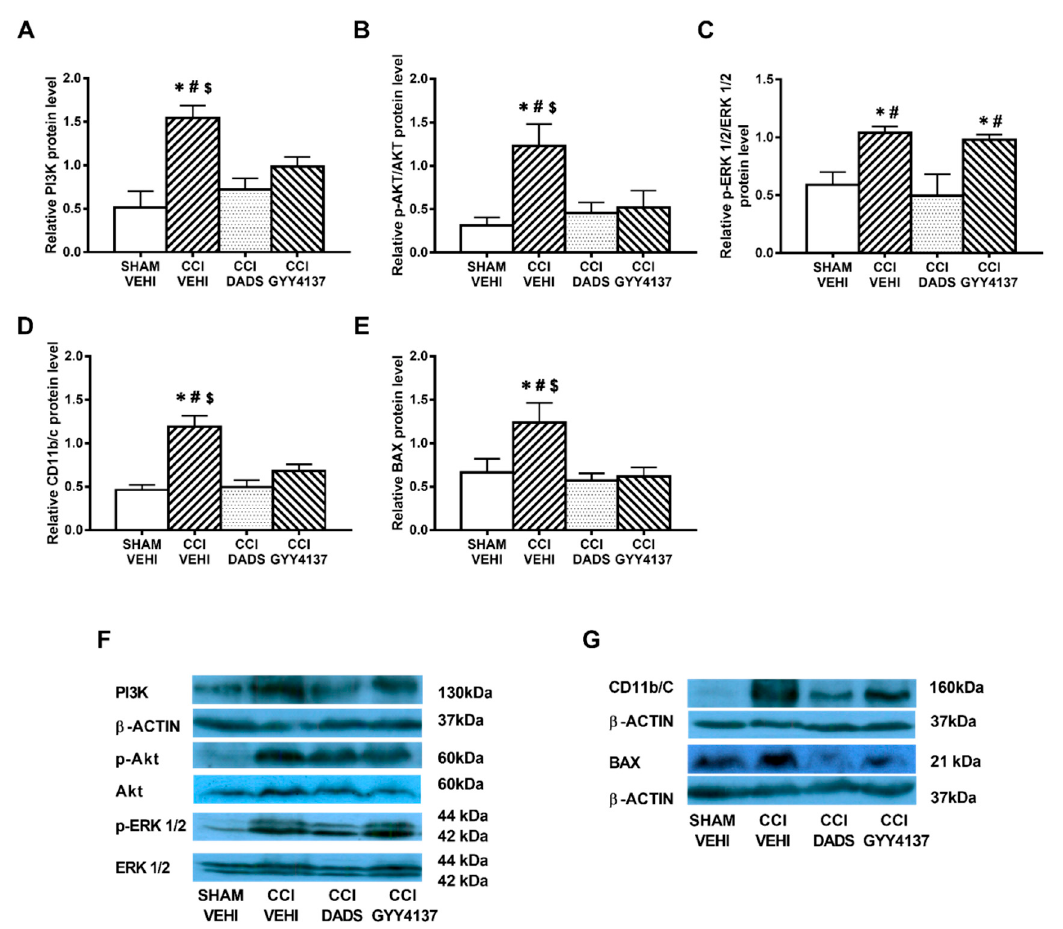
Figure 4. The effects of DADS and GYY4137 on the expression of PI3K, p-AKT, p-ERK 1/2, CD11b/c, and BAX in the AMG of animals with neuropathic pain. Treatment with DADS and GYY4137 normalized the up-regulation of PI3K ( A ), p-AKT ( B ), p-ERK 1/2 ( C ), CD11b/c ( D ), and BAX ( E ) in the AMG of animals with CCI-induced neuropathic pain. We used sham-operated mice treated with vehicle as controls. Non-phosphorylated proteins are expressed relative to β -actin protein levels while phosphorylated proteins are expressed relative to their corresponding total protein levels. Representative blots for PI3K, β -actin, p-Akt/Akt, and p-ERK 1/2/total ERK 1/2 ( F ) and for CD11b/c, BAX, and β -actin ( G ) are shown. In all panels, * represents significant differences vs. sham-operated mice treated with vehicle; # vs. sciatic nerve-injured mice treated with DADS; and $ vs. sciatic nerve-injured mice treated with GYY4137 ( p < 0.05; one-way ANOVA followed by the Student–Newman–Keuls test). Mean values ± SEM; n = 3–4 samples.